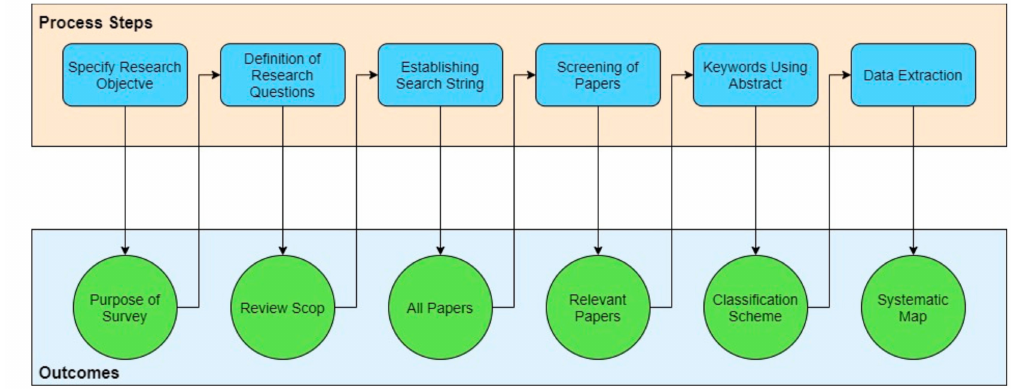
Figure 4. Research